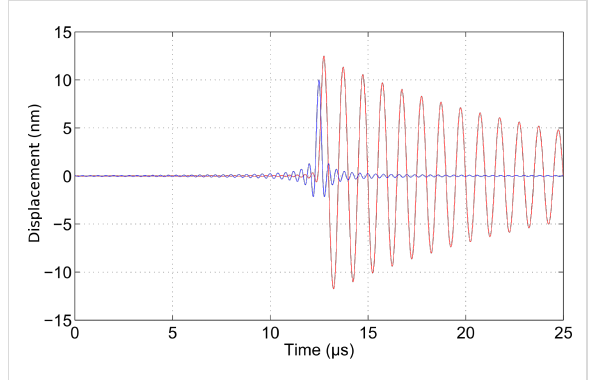
Figure 5: The response of a damped harmonic oscillator (red line, quality factor Q = 40) to a sinc driver (blue line) identical to that speci- fied in Figure 3.